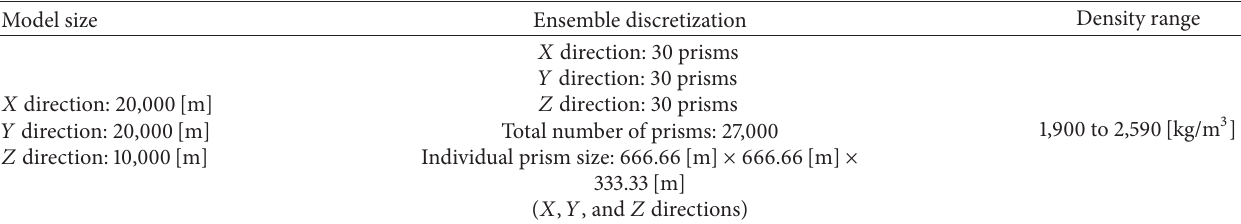
Table 2: 3D initial model main